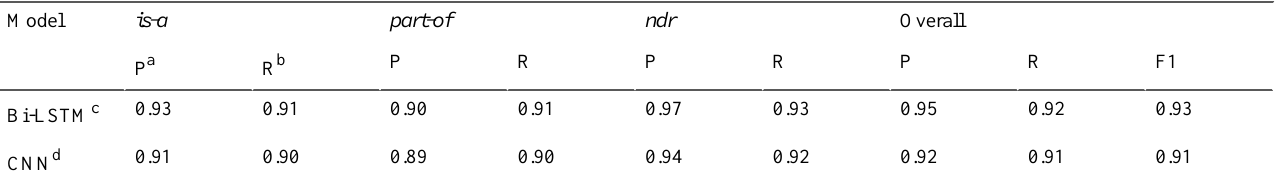
Table 1. Average performances of the 2 models on direct relation prediction (100 rounds).